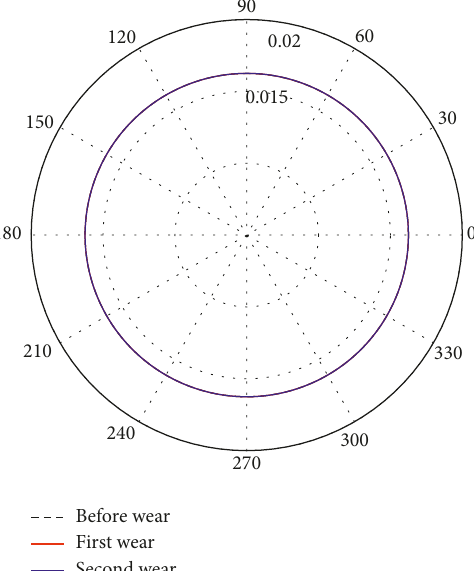
Figure 9: Bearing surface of joint A